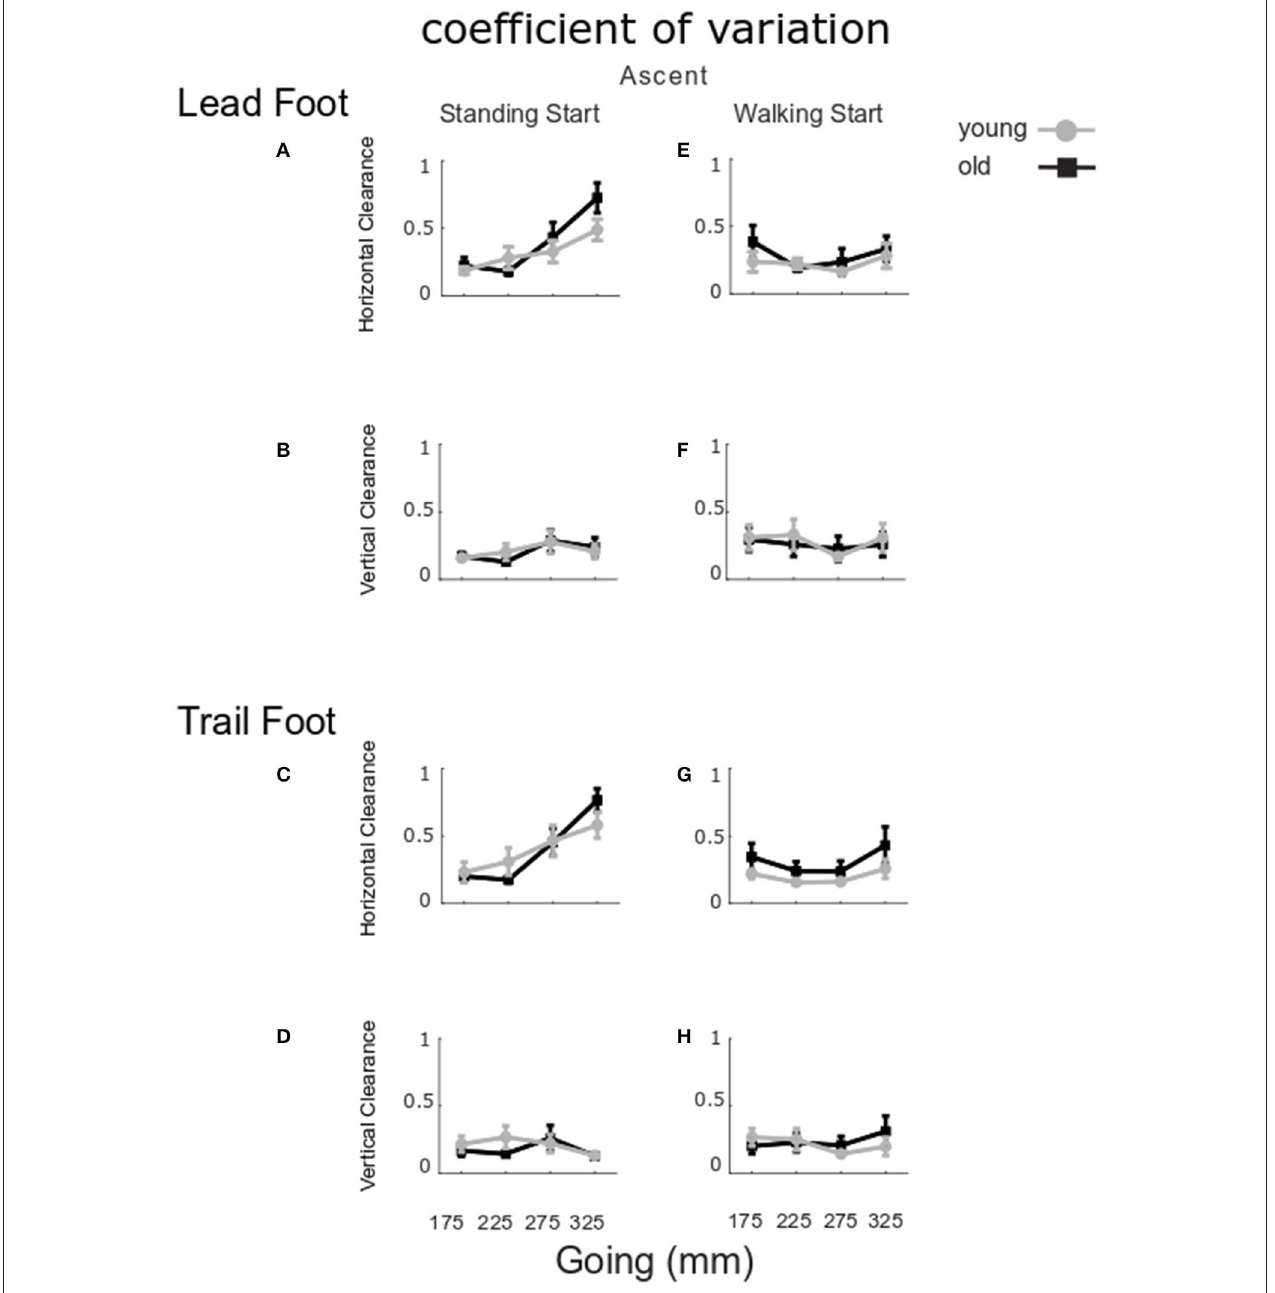
FIGURE 5 | Coefficient of variation for clearance in ascent. The group mean and SE for older (black) and younger (gray) coefficient of variation for clearance in stair ascent at the four goings. The values were calculated for standing start (left column) and walking start (right column). Coefficient of variation for lead foot clearance in horizontal (A,E) and vertical direction (B,F) ; trail foot clearance in horizontal (C,G) and vertical direction (D,H) .